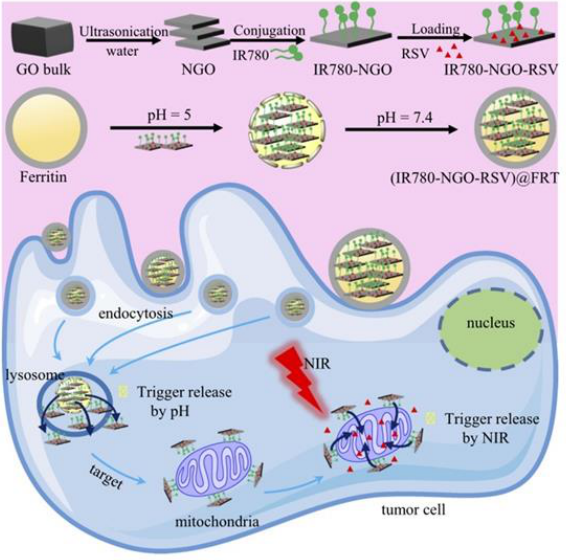
Figure 8. Assembly and in vivo release of drug dual-delivery system INR@FRT. Reproduced with permission from ref [62].